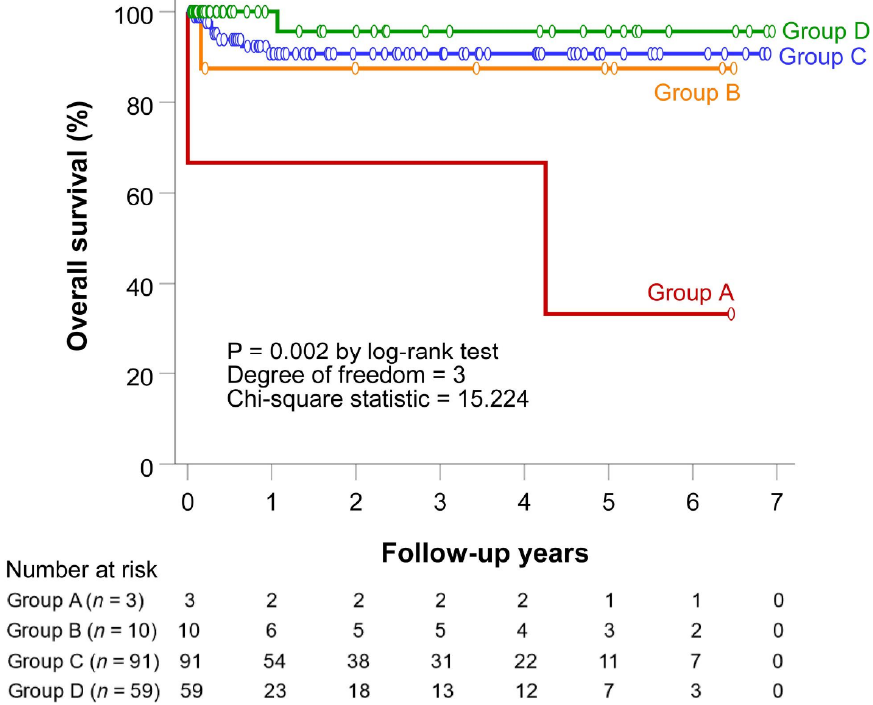
Figure 4. Overall survival of each patient group. Table 2. Demographic characteristics between group C1 (not receiving CT) and group C2/C3 (receiving